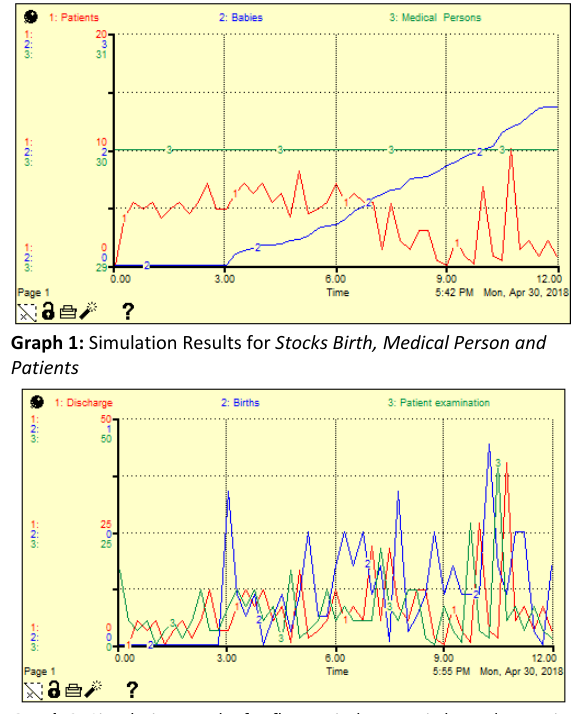
Figure 14. An SFD and resulting Simulations for a patient life